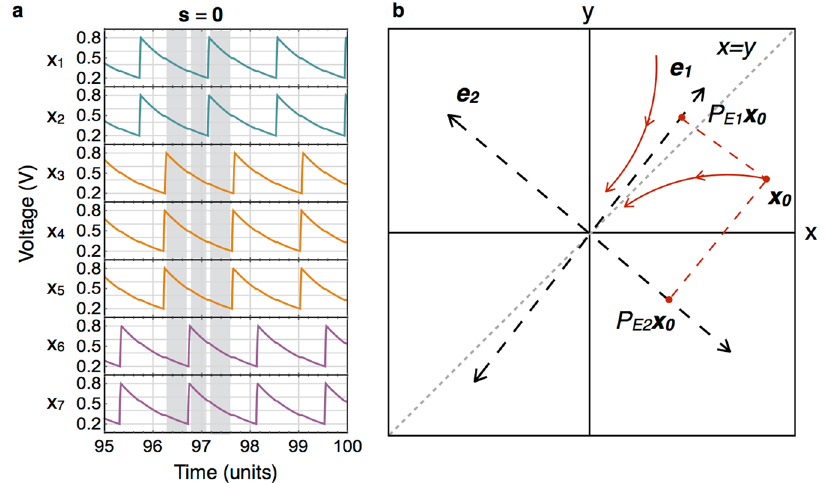
Figure 5. System dynamics and asymptotic permutation. ( a ) Simulation waveforms of a circuit connected in the 3-partite graph shown in Fig. 1a. The gray regions show the time when the system is in state s = 0. ( b ) Representative figure showing the relation between the asymptotic order of components of the state vector and the eigenspaces in a two-dimensional linear system where the coefficient matrix has negative